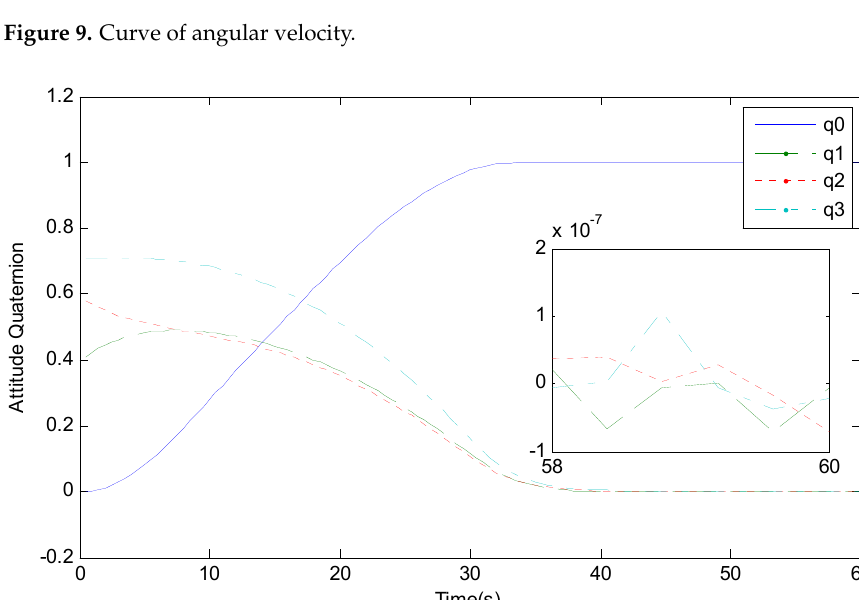
Figure 10. Curve of attitude quaternion.